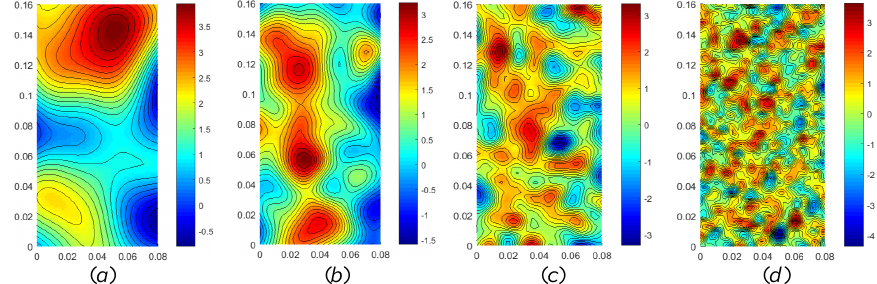
Figure 10. Random field realizations for cohesion with different correlation lengths, l c , equal to: ( a ) 40 mm, ( b ) 20 mm, ( c ) 10 mm, and ( d ) 5